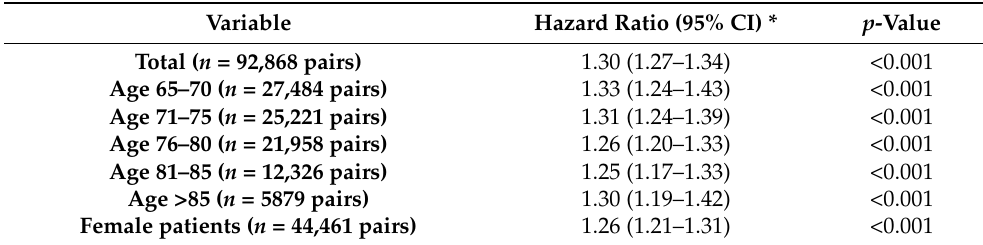
Table 2. Association between cancer and incident dementia within 10 years of the index date in patients followed in general practices in Germany (Cox regression